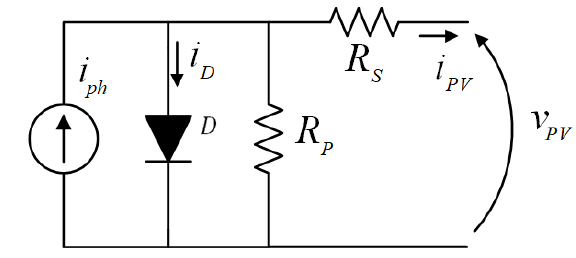
Figure 3. Equivalent circuit of the photovoltaic